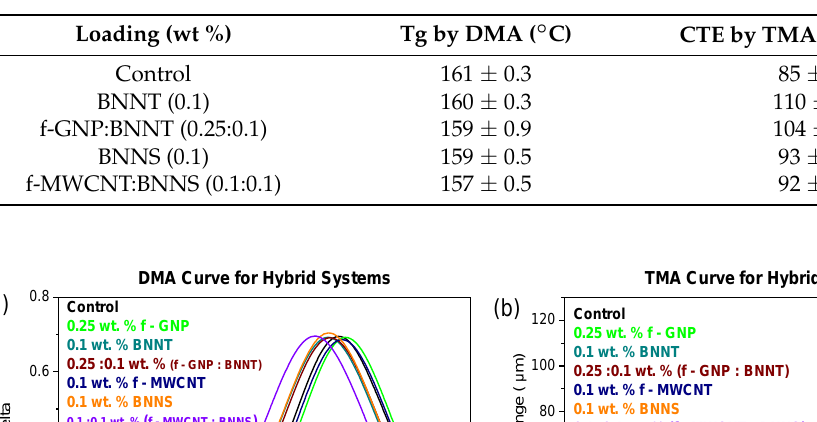
Table 6. Glass transition temperature T g and CTE of hybrid systems relative to the neat epoxy.